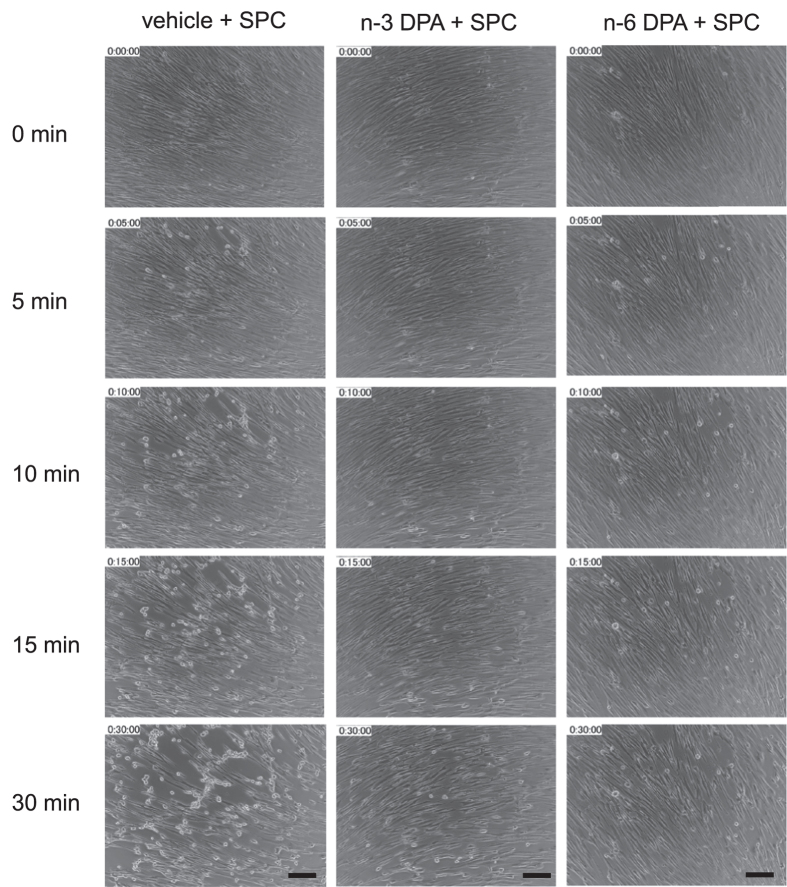
Live cell imaging of cellular contraction upon stimulation with SPC in CASMCs in the absence or presence of n-3 or n-6 DPA.Representative images of cells pretreated with n-3 or n-6 DPA and vehicle control after stimulation with SPC for different lengths of time. Scale bar = 10 μm.